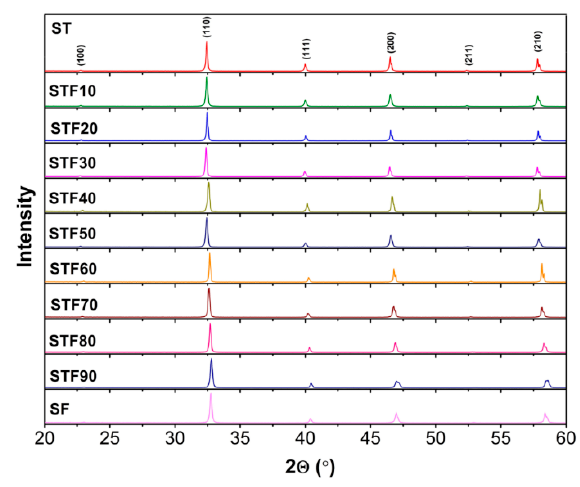
Figure 1. XRD patterns obtained for SrTi 1 − x Fe x O 3 − x / 2 − δ solid solutions.